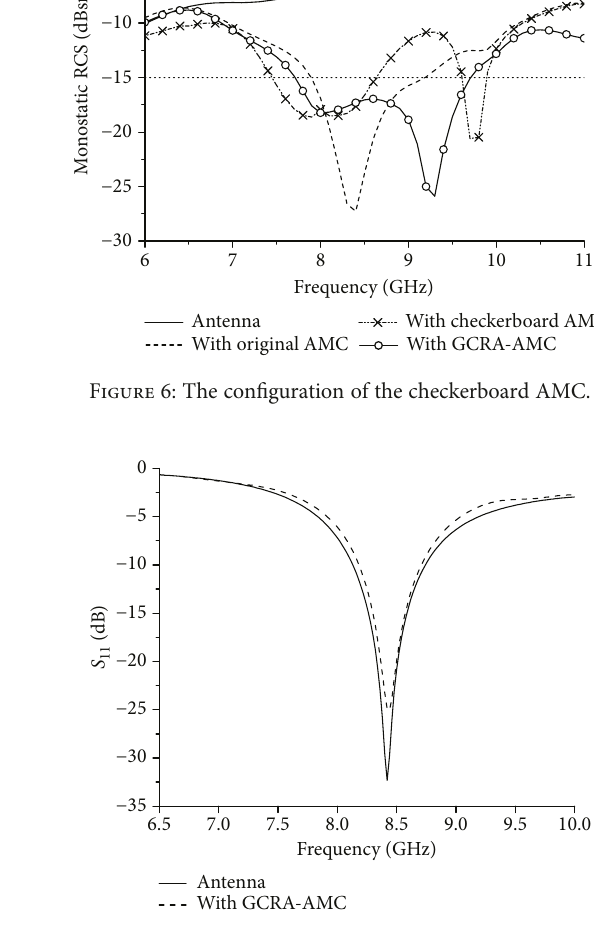
of the antenna. 11